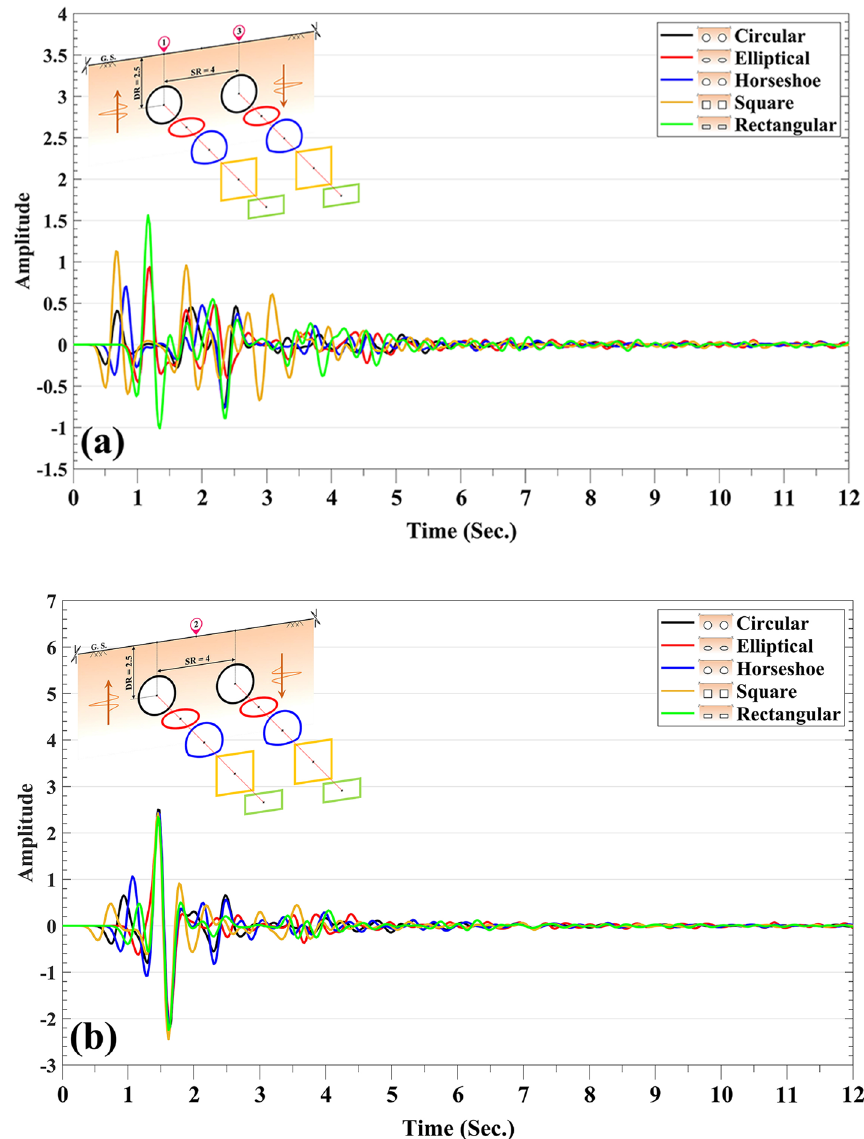
Fig. 3 The amplitude of propa- gated waves on the surface versus time, for the model of twin lined tunnels with differ- ent geometries in a centerline of the tunnels and b central point subjected to the vertical incident SH